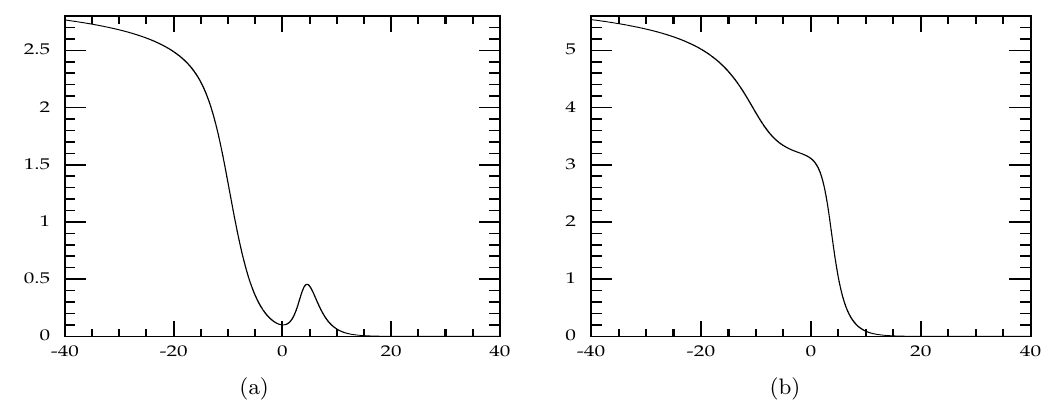
Figure 8 . SU(3) (cid:12)elds | case II; (cid:12)elds (a) ’ 1 and (b) ’ 2